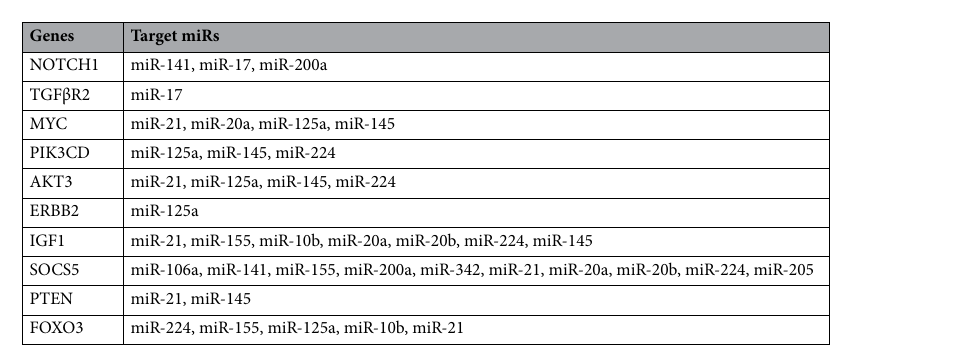
Table 4. The list of selected genes involved in breast cancer